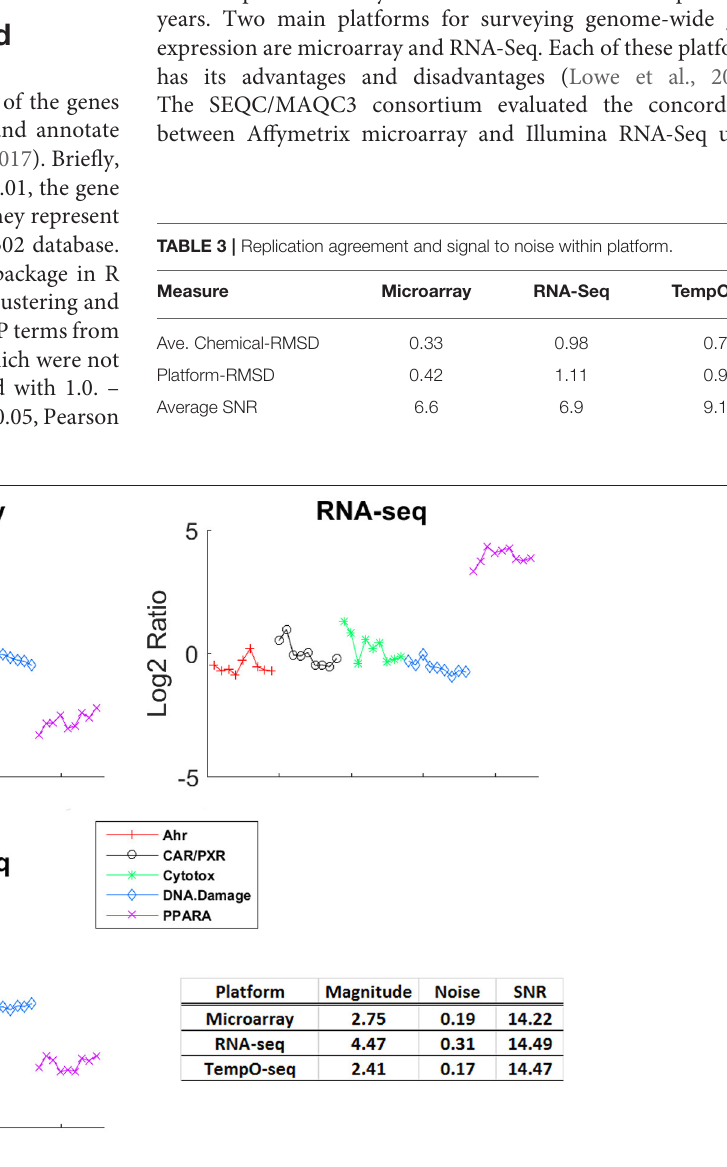
FIGURE 3 | Gene expression patterns with maximal signal to noise. For each platform, the EPIG pattern with the maximal signal to noise ratio (SNR) is shown. The y-axis is the log 2 ratio of gene expression (treated to the average of the control [matched according to nutritional status of the vehicle]), the x-axis is the samples grouped by MOA (represented by the colors and symbols in the legend). The table inset displays the magnitude of fold change, the noise and the SNR for each of the patterns